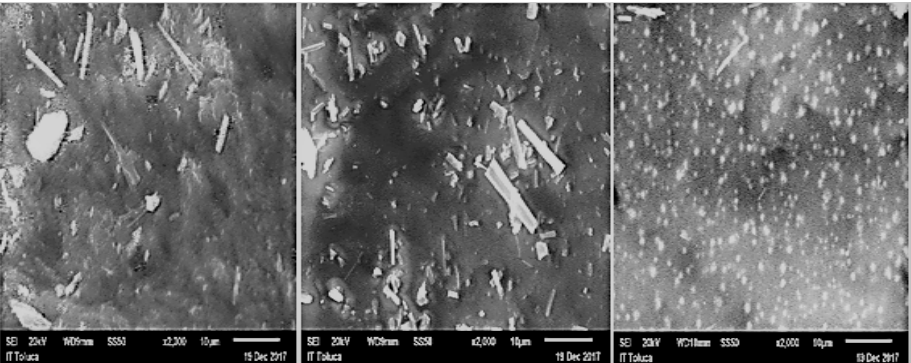
Figure 2. Micrographs from Scanning Electron Microscopy (SEM) of alginate-Collagen (SA-CO), Alginate-Arabic gum (SA-AG) and Alginate-Gelatin (SA-GE) capsules surface; from left to right, loaded loaded with f4 peptide fraction. with f4 peptide